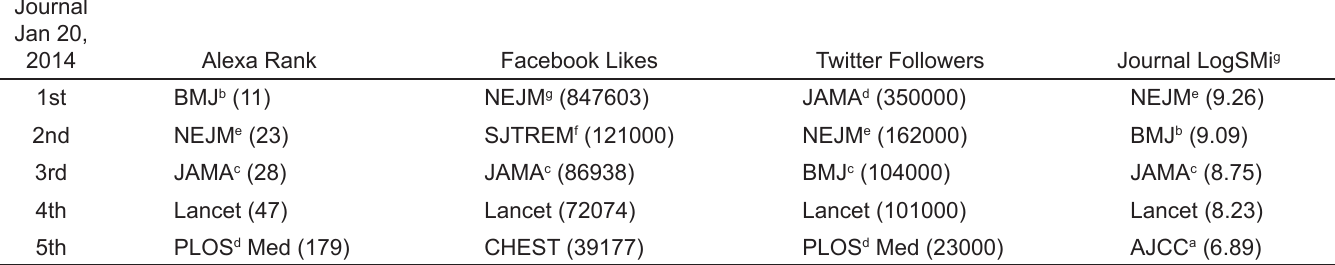
Table 3b. The top five journals as calculated by the Social Media index and its components.